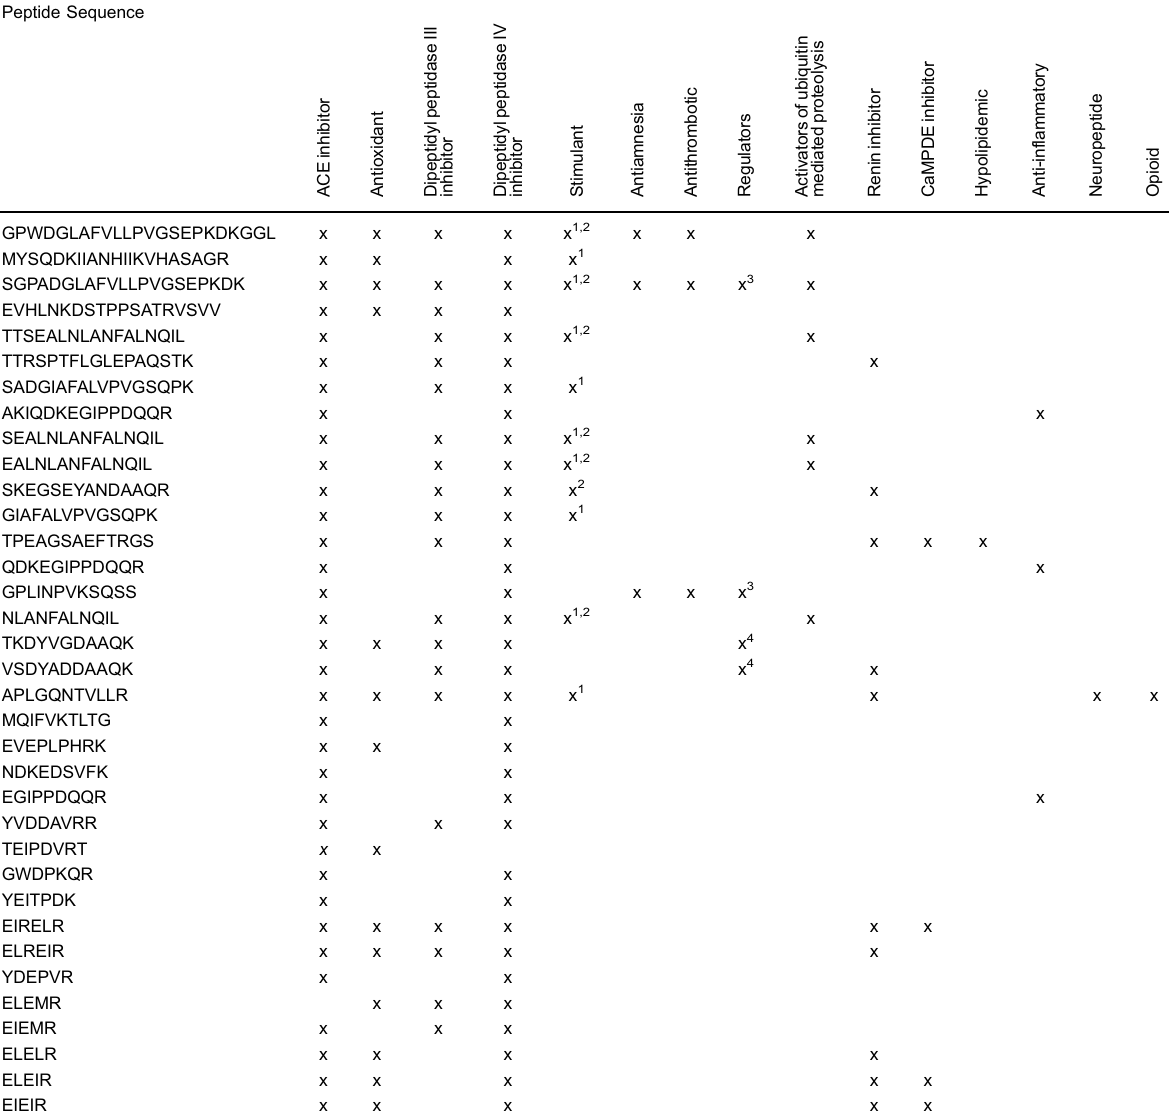
Table 1. Sequence and bioactive potential of the identi fi ed peptides present in Phaseolus vulgaris (PV3) organized by size, from largest to smallest. Peptide Sequence